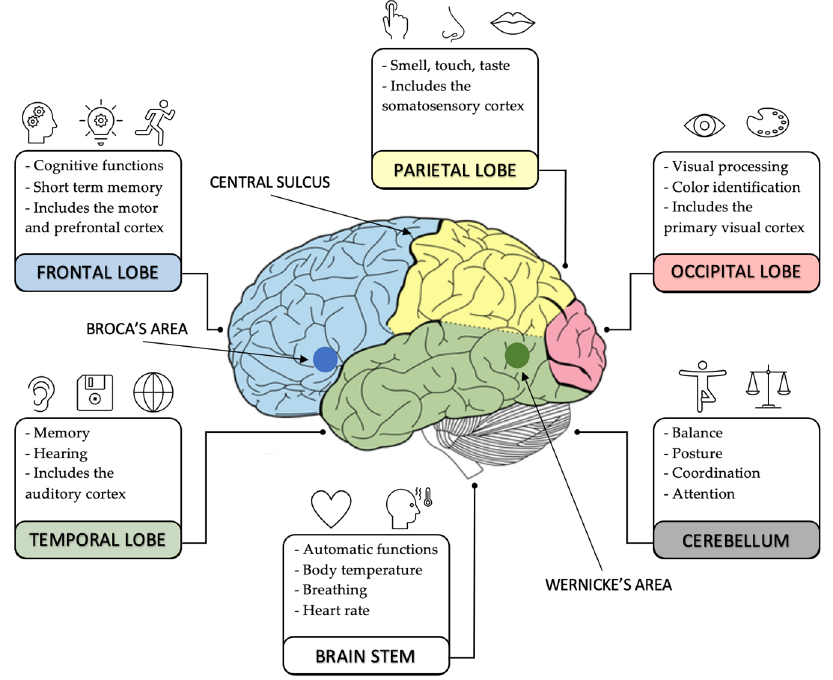
Figure 2. Brain lobes and sub-areas. Brain image obtained from